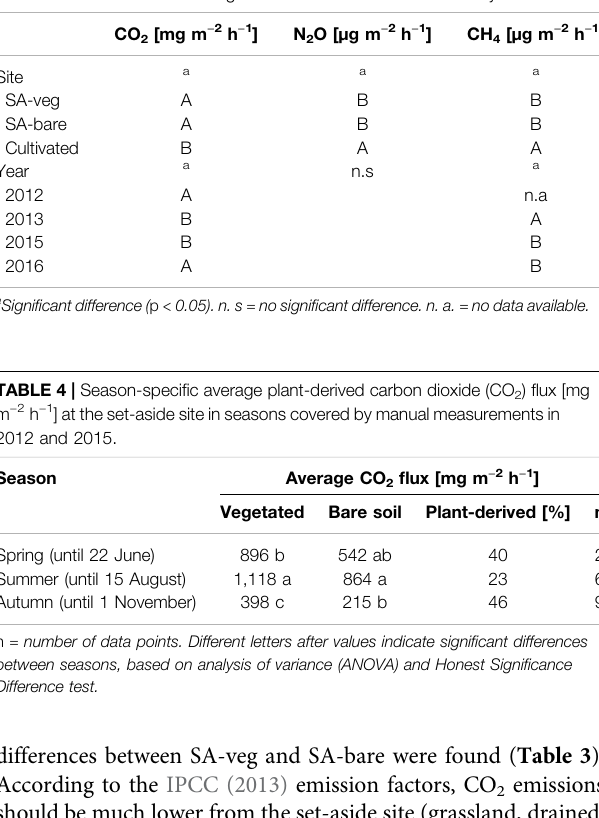
TABLE 3 | Differences in greenhouse gas (GHG) fl uxes determined by manual measurements between the set-aside (SA) and cultivated sites and between years, based on analysis of variance (ANOVA) and Honest Signi fi cant Difference test. Different letters indicate signi fi cant differences between sites/years.